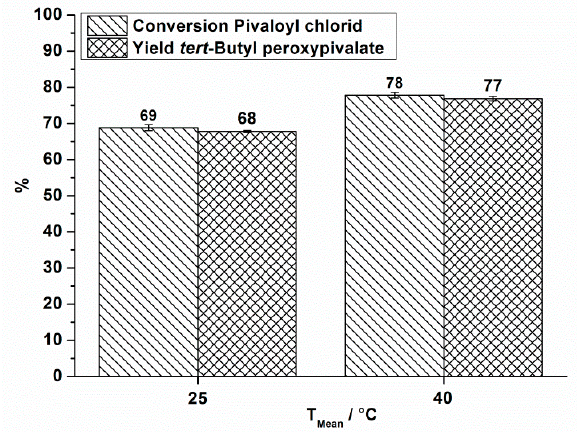
Figure 4 : OMR, conversion and yield of TBPP synthesis, 2nd reaction step at a total flow rate of 18.5 mL·min − 1 depending on the reaction temperature.